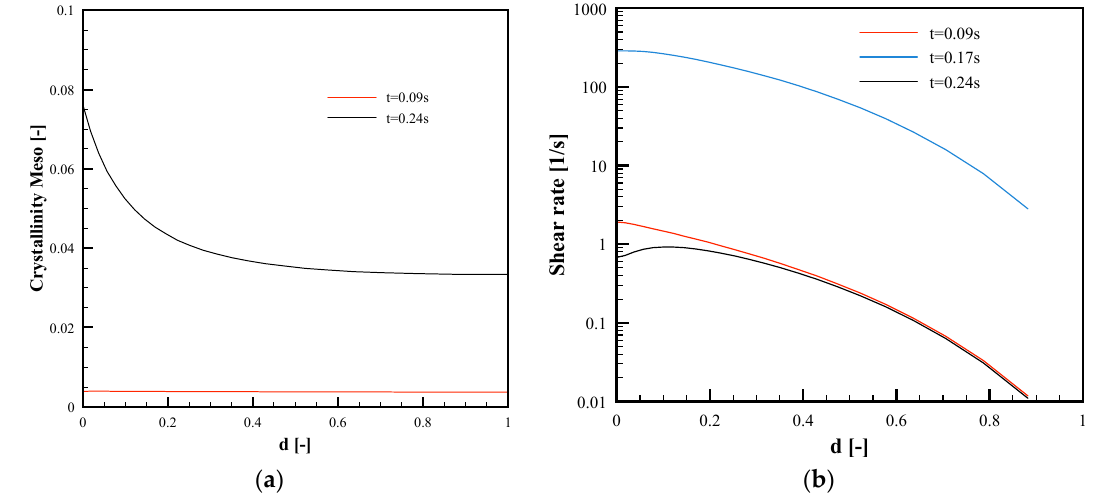
Figure 10. Mesophase crystallinity ( a ) and shear rate ( b ) distributions along the dimensionless half thickness, d , in position L1 for the Passive condition.